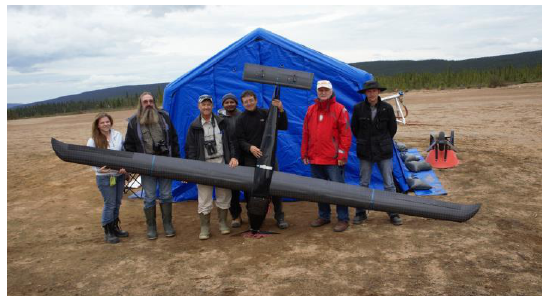
Figure 19: Researchers and Brican team for BLOS testing and caribou